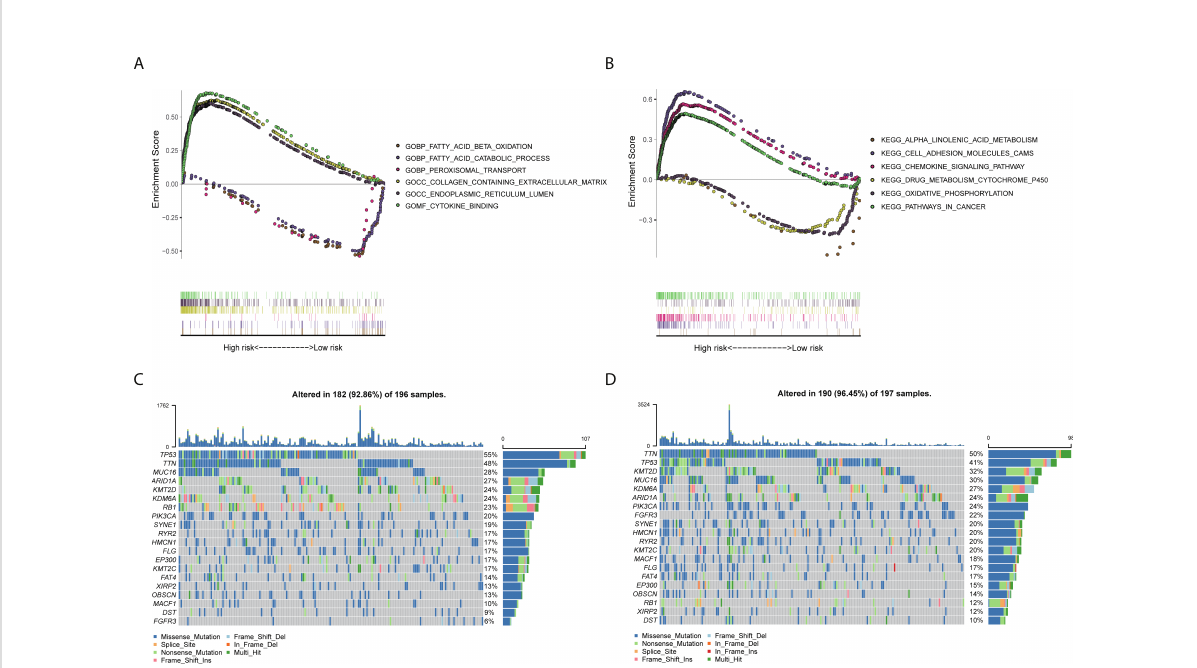
FIGURE 7 The results of GSEA and gene mutation analyses. (A) According to GO enrichment analysis, ERS-related lncRNAs were may be involved in fatty acid metabolism, peroxidation, extracellular matrix, endoplasmic reticulum, and cytokines. (B) KEGG pathway analysis showed that these lncRNAs may be associated with functions such as cell adhesion, cytokines, drug metabolism, tumor pathways, and oxidative phosphorylation. (C, D) Waterfall plots of gene somatic mutations in high- and low-risk patients,